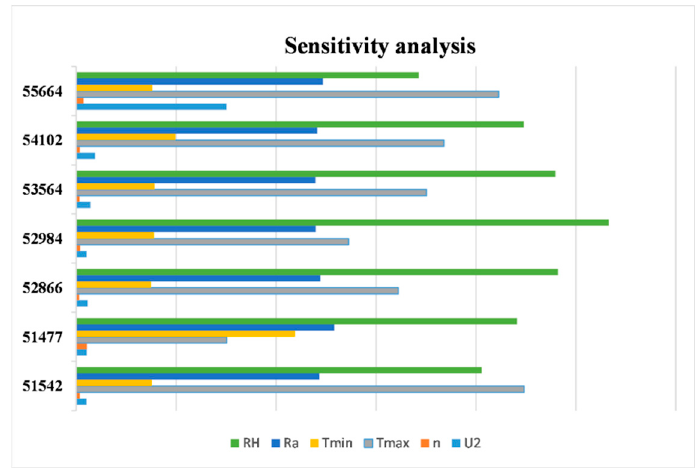
Figure 4. Sensitivity analysis of different factors to ET O .